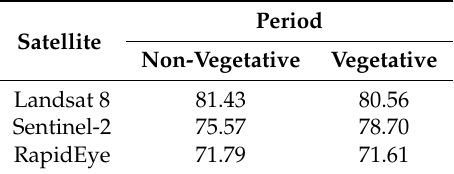
Table 4. Overall Accuracy (OA) for the Random Forest (RF)-classification outputs